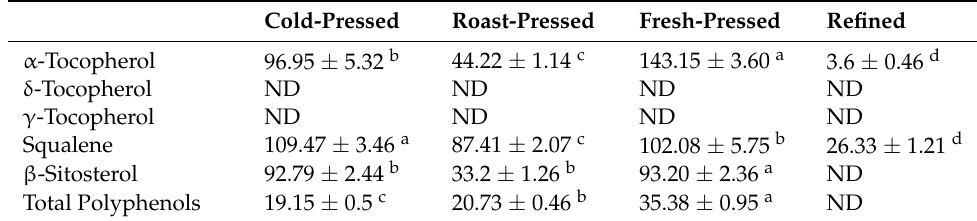
Table 3. Bioactive compounds (mg/kg) of camellia